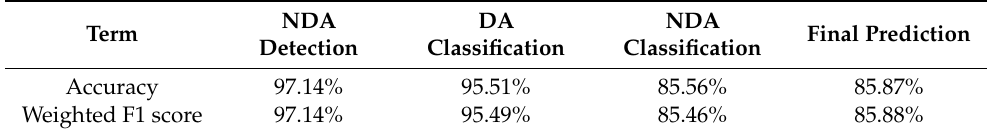
Table 1. Performance of 3D CNN